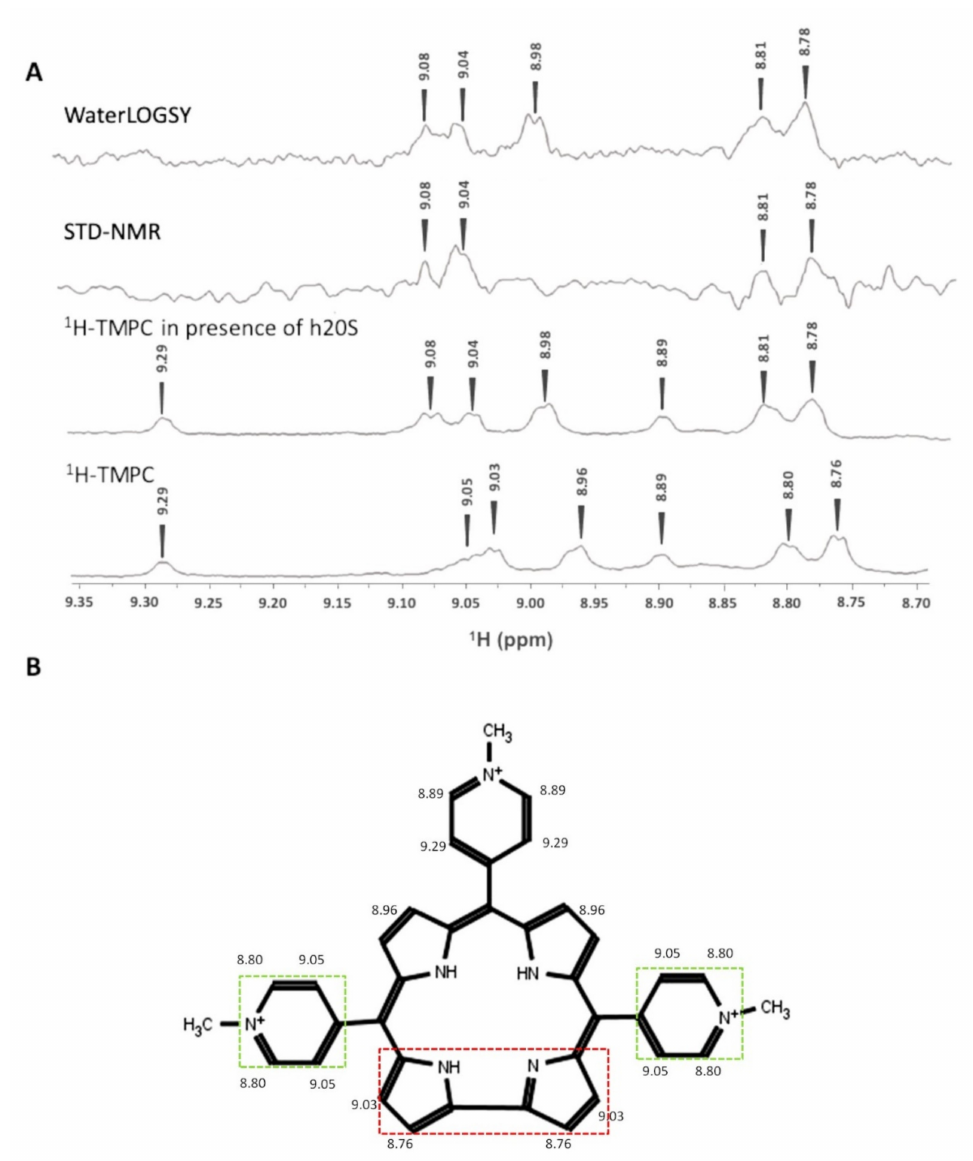
Figure 6. ( A ) Low-field of 1 H NMR spectrum of TMPC (175 µ M) in the buffer (50 mM Hepes, 100 mM NaCl, and 1mM DTT) and in the presence of h20S proteasome (860 nM); STD-NMR and WaterLOGSY spectra (from the bottom to the top). ( B ) Structure of the TMPC reporting 1 H chemical shift assignments and highlighting the 1 H TMPC resonances visible in STD (broken line in red and in green) and in WaterLOGSY (broken line in red)